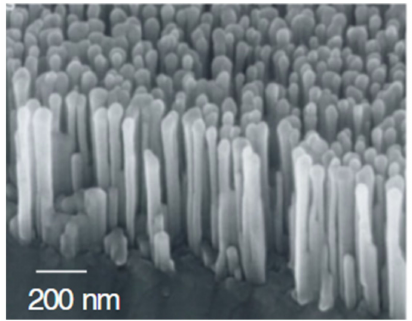
Figure 10. SEM image of GaN nanopillars on sapphire. Reproduced from [116]. with permission from Copyright WILEY-VCH Verlag GmbH & Co. KGaA,